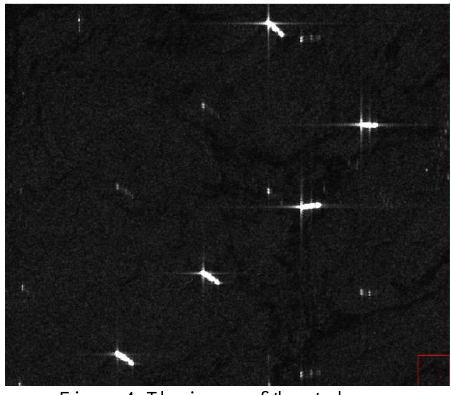
Figure 4. The image of the study area